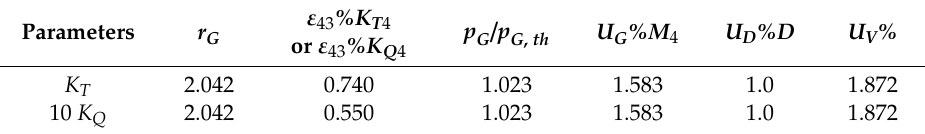
Table 5. Verification and validation for the thrust and torque coe ffi cients computed for J = 1.283.